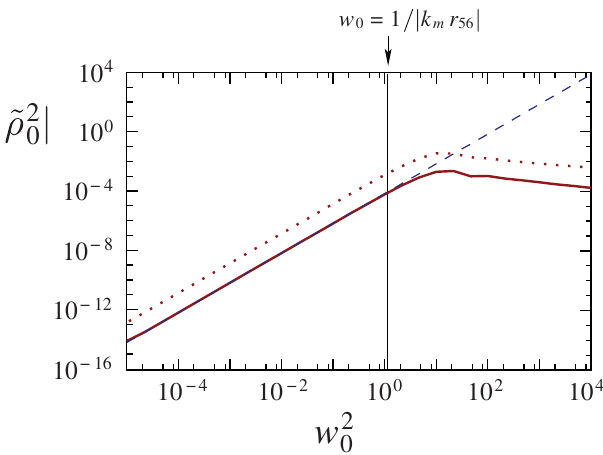
FIG. 12. (Color) Scaling of the terahertz emission power versus laser pulse power [numerical computation using Eq. (A13), and r 56 j ]. analytic results from Eq. (B16) valid when w 0 (cid:7) 1 = j k m Full and dashed lines are the maximum value of j ~ (cid:8) 2 0 ð k Þj com- puted numerically, and analytically, respectively (the two are indistinguishable in practice for w 0 < 1 here). Dotted line: the R j ~ (cid:8) 2 0 ð k Þj dk computed numerically. Note that w 2 0 main peak area R j ~ (cid:8) 2 0 ð k Þj dk is is proportional to the laser power, and that ¼ 0 : 3 , r 51 ¼ proportional to terahertz pulse energy. (cid:9) L ¼ 400 . (cid:1) 0 : 000 53 , r 52 ¼ 0 : 0021 , r 56 ¼ (cid:1) 0 : 0029 , and k m